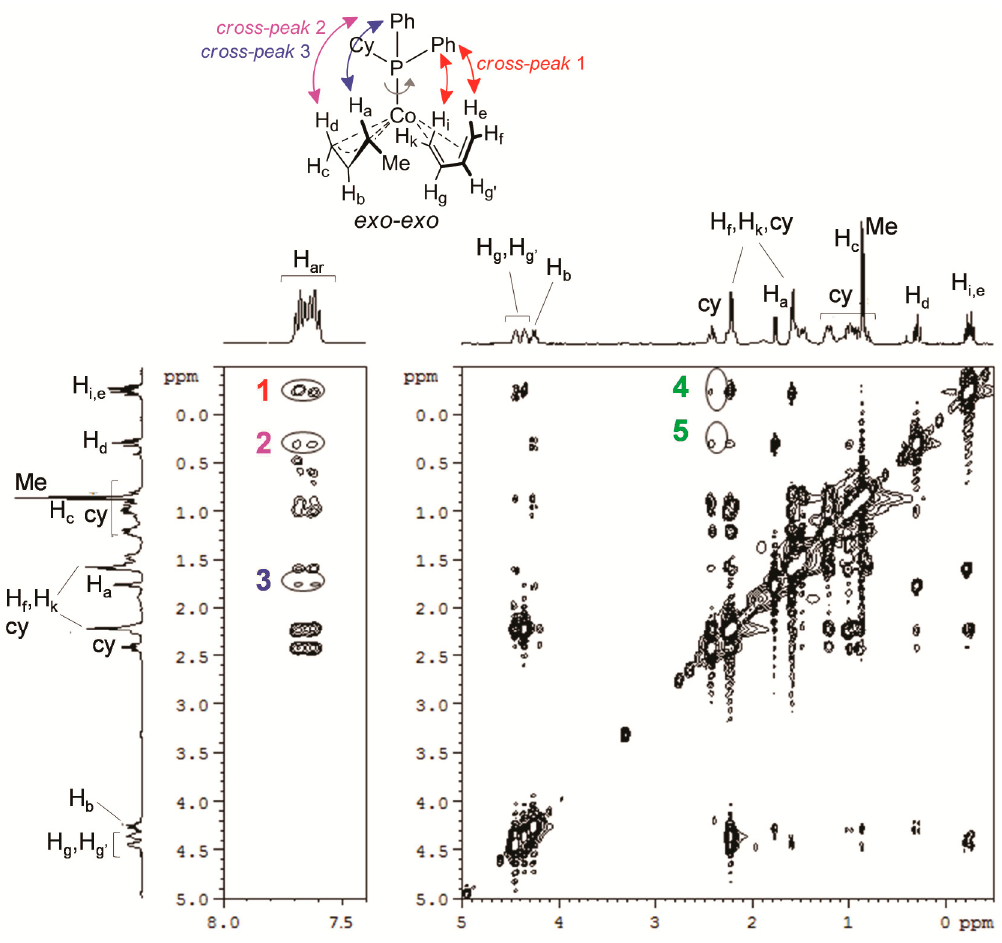
Figure 4. 1 H NMR spectra of ( η 3 ‐ C 5 H 9 )( η 4 ‐ C 5 H 8 )Co(PMePh 2 ) ( 3 ) (Me P indicates the protons of the methyl on the ligand phosphorus atom, H ar = aryl protons).